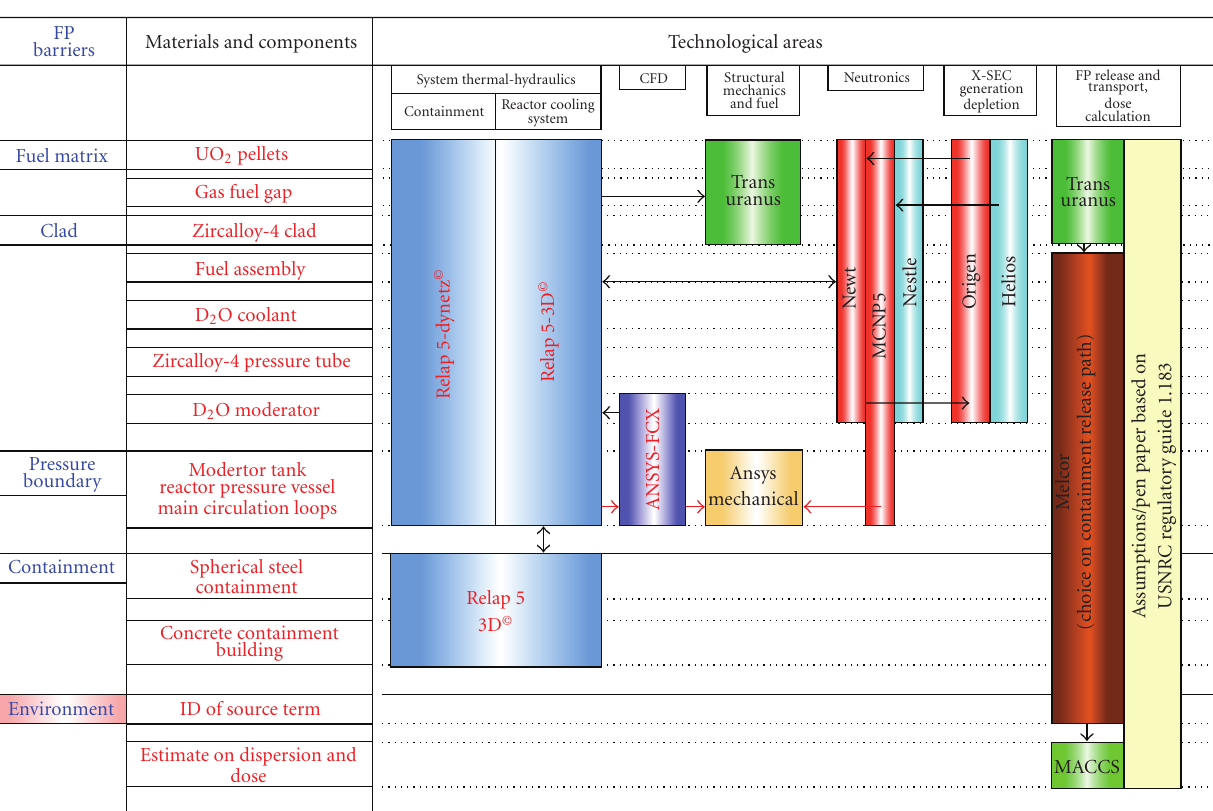
Figure 2: The interaction among the computer codes used for BEPU accident